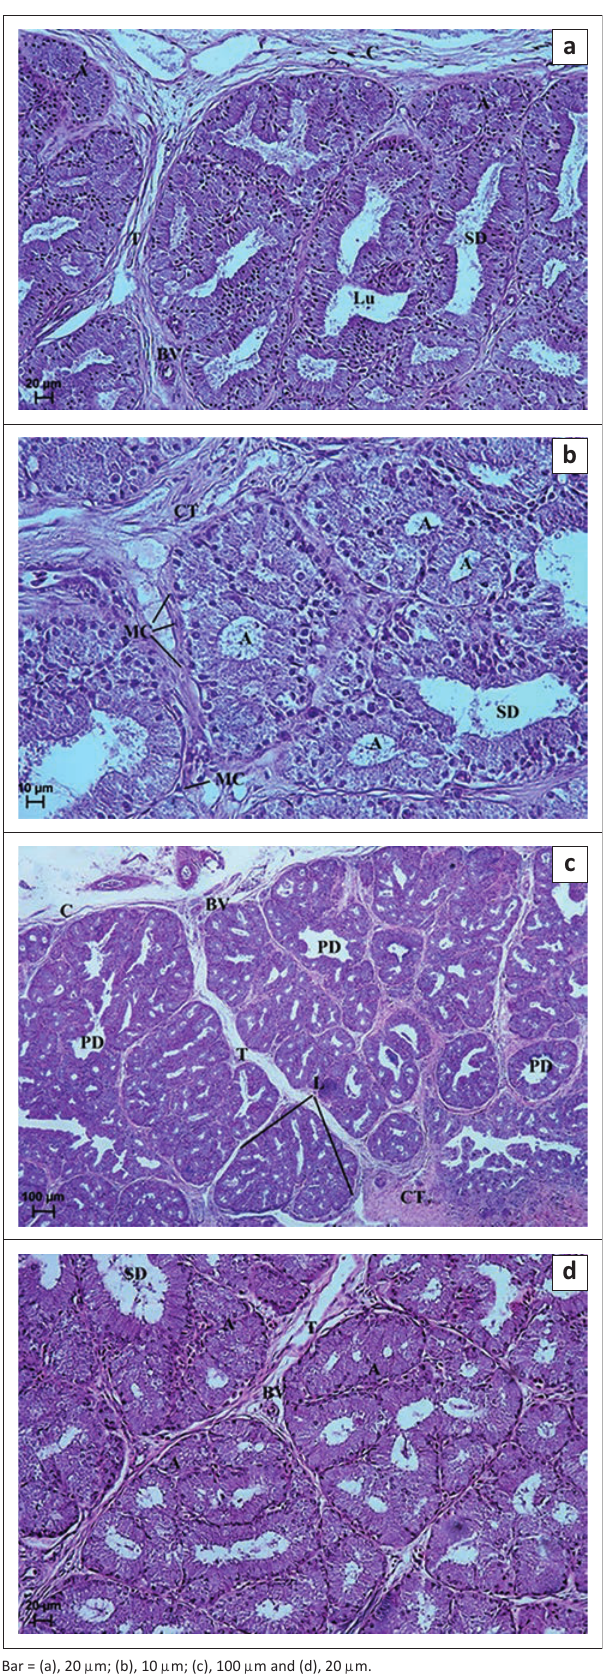
FIGURE 6: Light micrograph of the lacrimal gland in African black ostrich in group 3. (a) 2-weeks-old, (b) 2-weeks-old, (c) 3-weeks-old and (d)